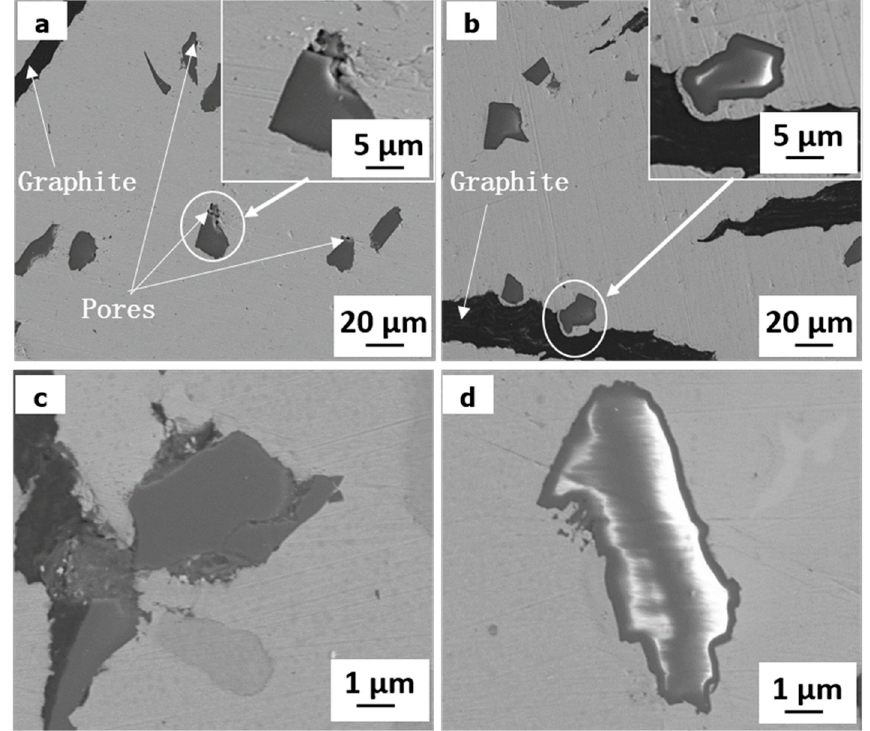
Figure 3. SEM morphologies of the composites: ( a , c ) uncoated SiO 2 ; ( b , d ) Cu-coated SiO 2 .